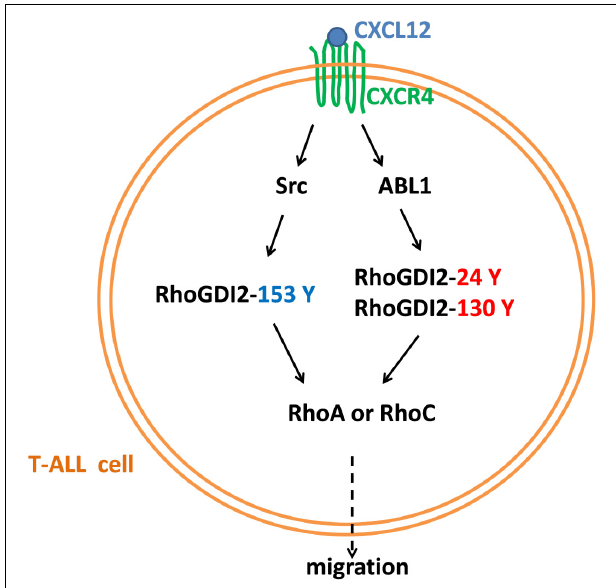
FIGURE 10 | A diagram of the mechanism of CXCR4-mediated T-ALL